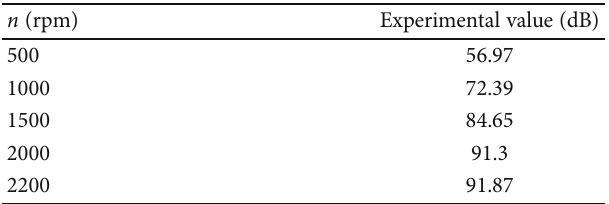
Table 2: Total sound pressure level of propeller at no. 10 measuring point of propeller (A).